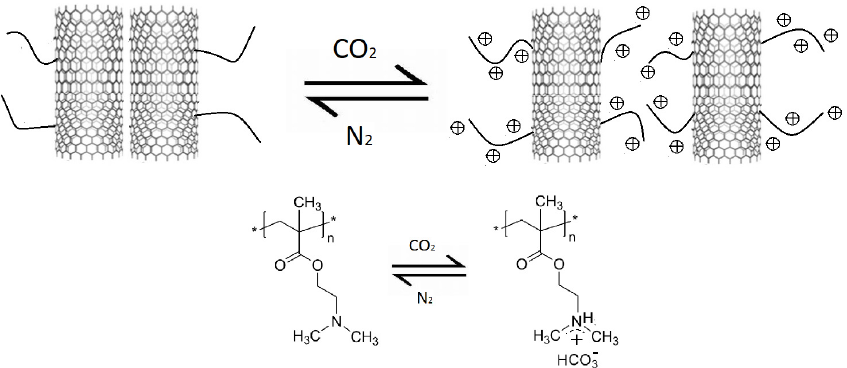
Figure 4. UV-Vis spectra of MWCNT-PDA-PDMAEMA in water, inset ( a ) before CO 2 purge and ( b ) after CO 2 purge. Scheme 1. The reaction between composite and CO 2 leads to the separation of CNT bundles.